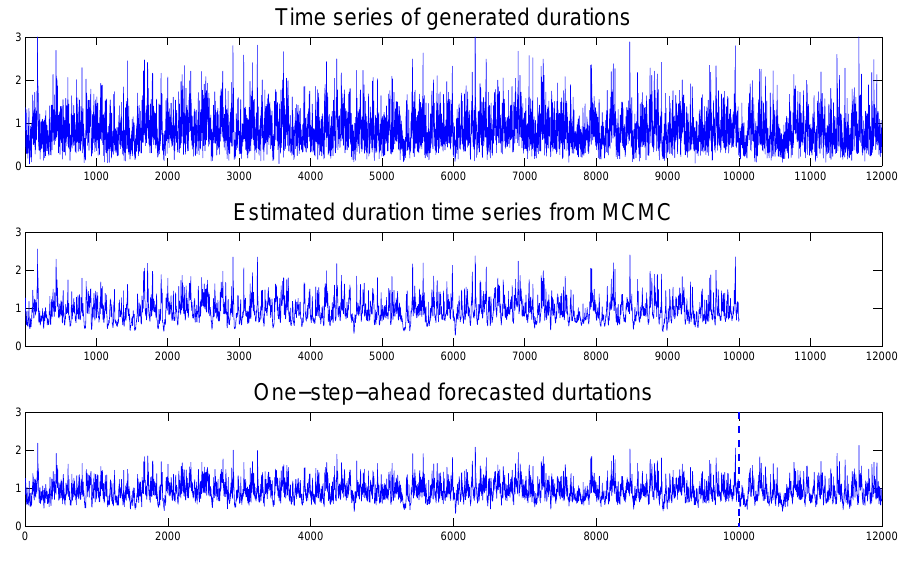
Figure 6. Comparison between observed durations with the estimated and one-step-ahead forecasted conditional durations based on the TSCD-W model using the simulated transaction